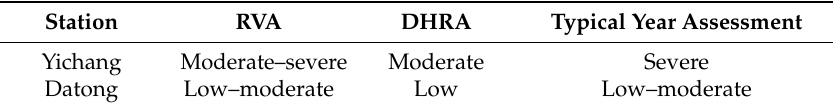
Table 9. Comparing the results of flow regime change by three